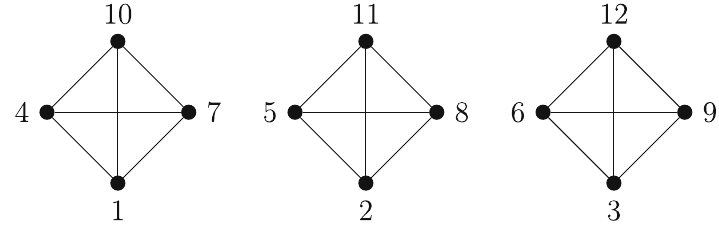
Figure 5: Subgraph H of (cid:2) ( ) ConeG 3 induced by the vertices = { } V 1, 2, 3,…, 12